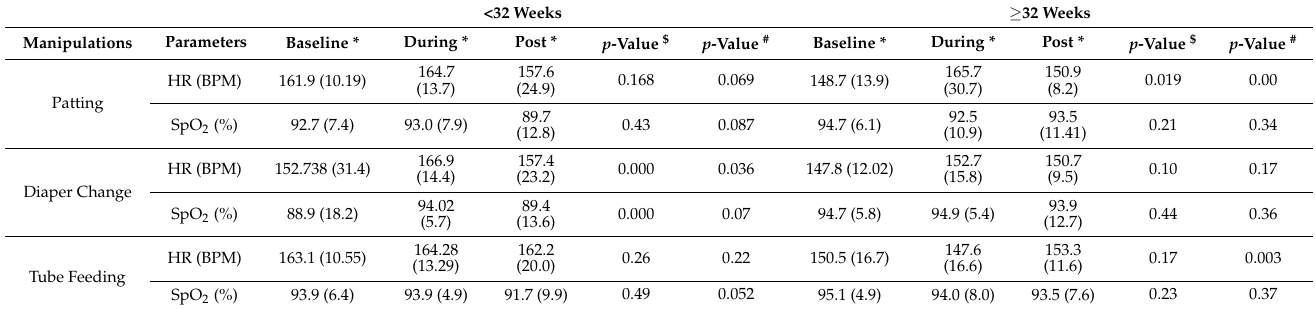
Table 6. Physiological parameters (HR and SpO 2 ) before, during, and after manipulation. <32 Weeks ≥ 32